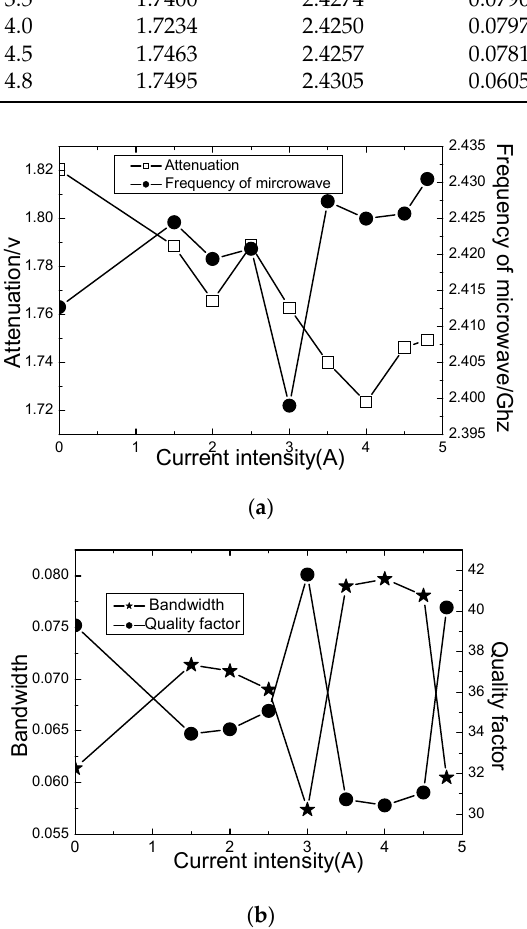
Figure 7. Relationship between current intensity and ( a ) attenuation and microwave frequency; and ( b ) bandwidth and quality factor.